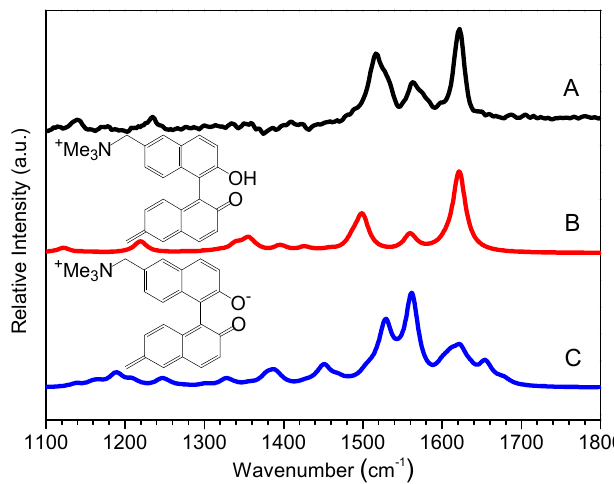
Figure 7. ( A )Experimental BQMP-b TR 3 spectrum (at 1µs) seen in MeCN:H 2 O (1:1, pH = 12) compared to a density functional theory (DFT)-calculated Raman spectrum of ( B ) BQM and ( C ) BQM − species.